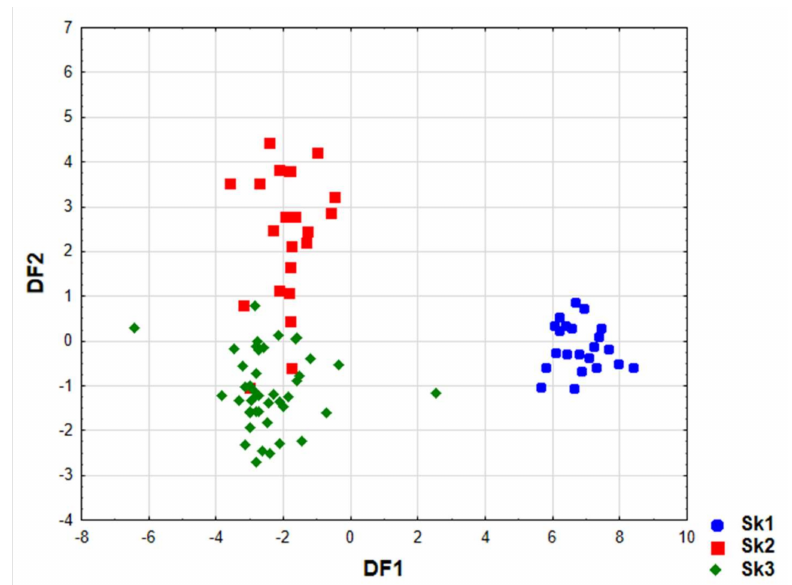
Figure 5. Scatter plot of canonical values for DF1 and DF2